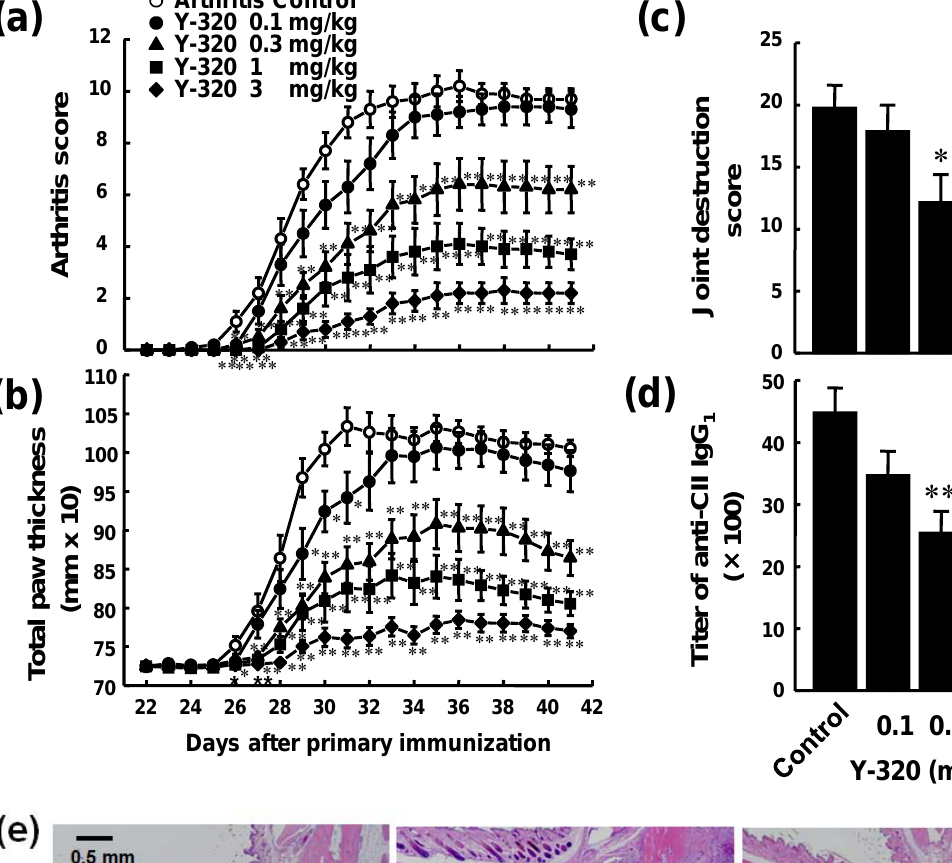
Figure 3. Prophylactic administration of Y-320 inhibits CIA in DBA/1J mice. Y-320 was administered orally to mice from the day of primary immunization for 6 weeks.